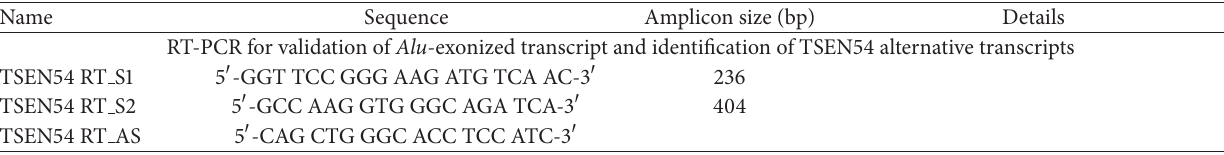
Table 1: List of oligonucleotides used in this